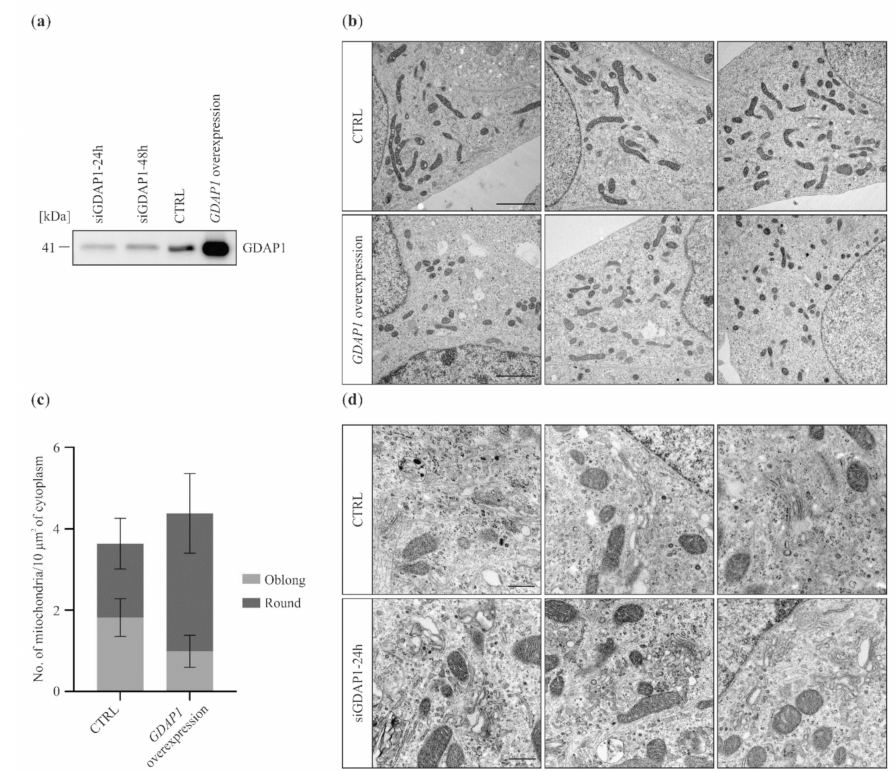
Figure 1. GDAP1 levels in SH-SY5Y cells determines the morphology of mitochondria and the Golgi. ( a ) The level of GDAP1 following 24 or 48 h of siRNA silencing, and after GDAP1 overproduction. Western blot analysis of total cell extracts using an anti-GDAP1 antibody. ( b ) Electron micrographs presented mitochondrial morphology in cells overexpressing GDAP1 . Scale bar 2 µ m. ( c ) Quantification of results from ( b ). ( d ) Morphology of the Golgi following GDAP1 gene silencing in SH-SY5Y cells on electron micrographs. Scale bar 500